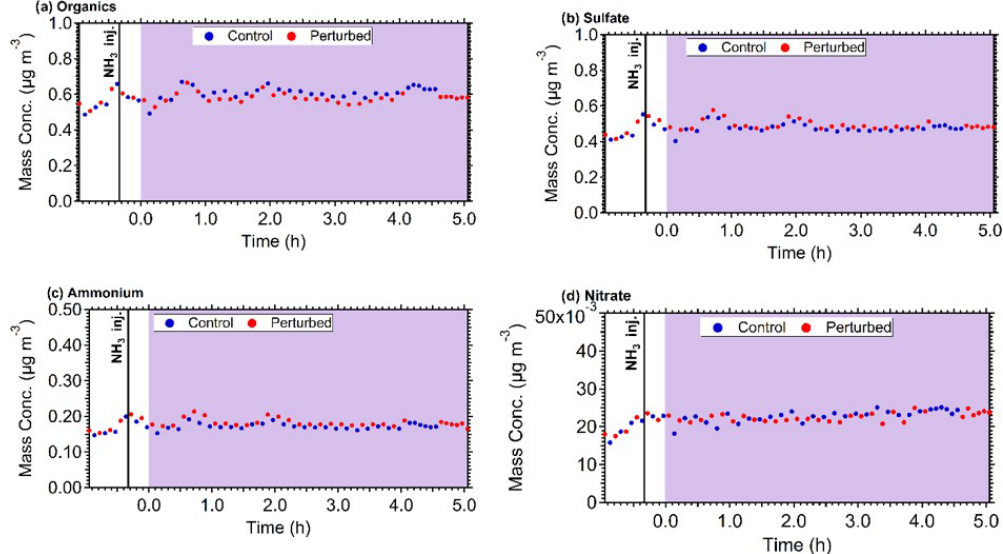
Figure 5. The wall loss corrected mass concentration of (a) organics, (b) sulfate, (c) ammonium, and (d) nitrate in the control (blue dots) and perturbed (red dots) chamber during Exp. B1. The purple shades region represents the time that the chambers were under UV